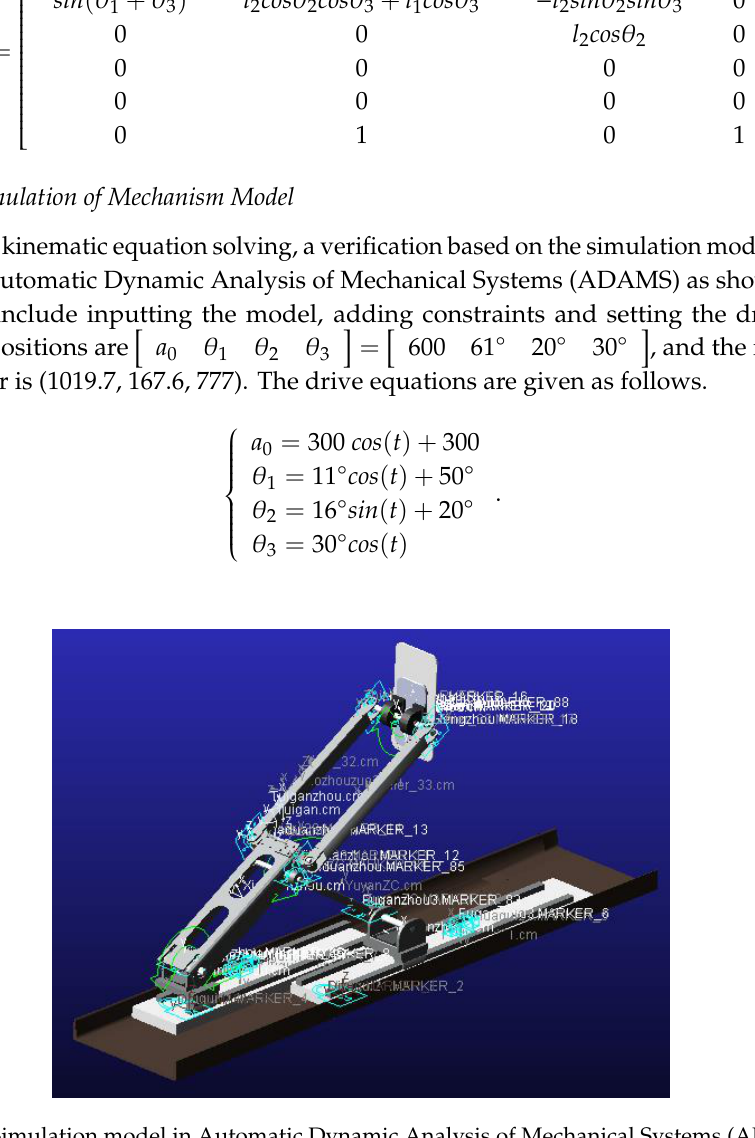
Figure 7. Simulation model in Automatic Dynamic Analysis of Mechanical Systems (ADAMS).